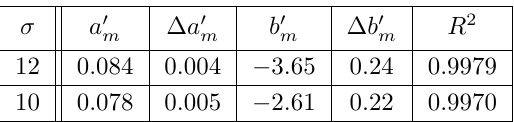
= 3 . ∆ a 0 are the uncertainties of parameters a 0 , ∆ b 0 a m m